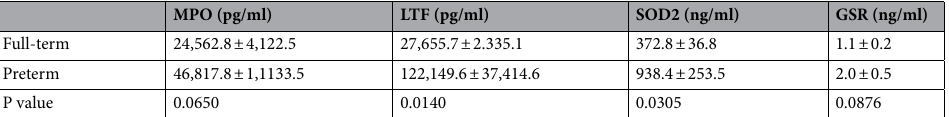
Table 3. The abundances of four biomarker proteins in full-term and preterm sets. We determined the concentrations of MPO, LTL, SOD2 and GSR in amniotic fluid with ELISA as well as the p values. Data are presented as the mean ± SD. The p values were calculated based on t